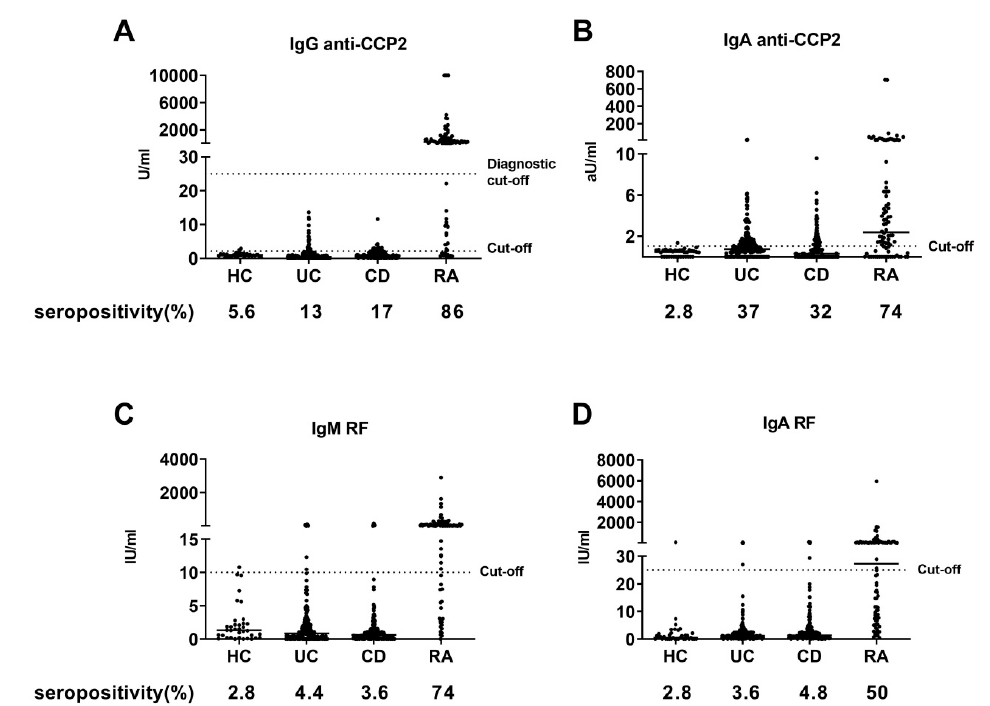
Figure 1. Arthritis Autoantibody (AAb) levels for healthy controls (HC, n = 36), Ulcerative colitis (UC, n = 226), Crohn’s disease (CD, n = 165) and rheumatoid arthritis (RA, n = 86) patients. ( A ) IgG anti-CCP2 levels; ( B ) IgA anti-CCP2 levels; ( C ) IgM RF levels and ( D ) IgA RF levels. U / mL = Units / mL; aU / mL = arbitrary units / mL; IU / mL = International units / mL.